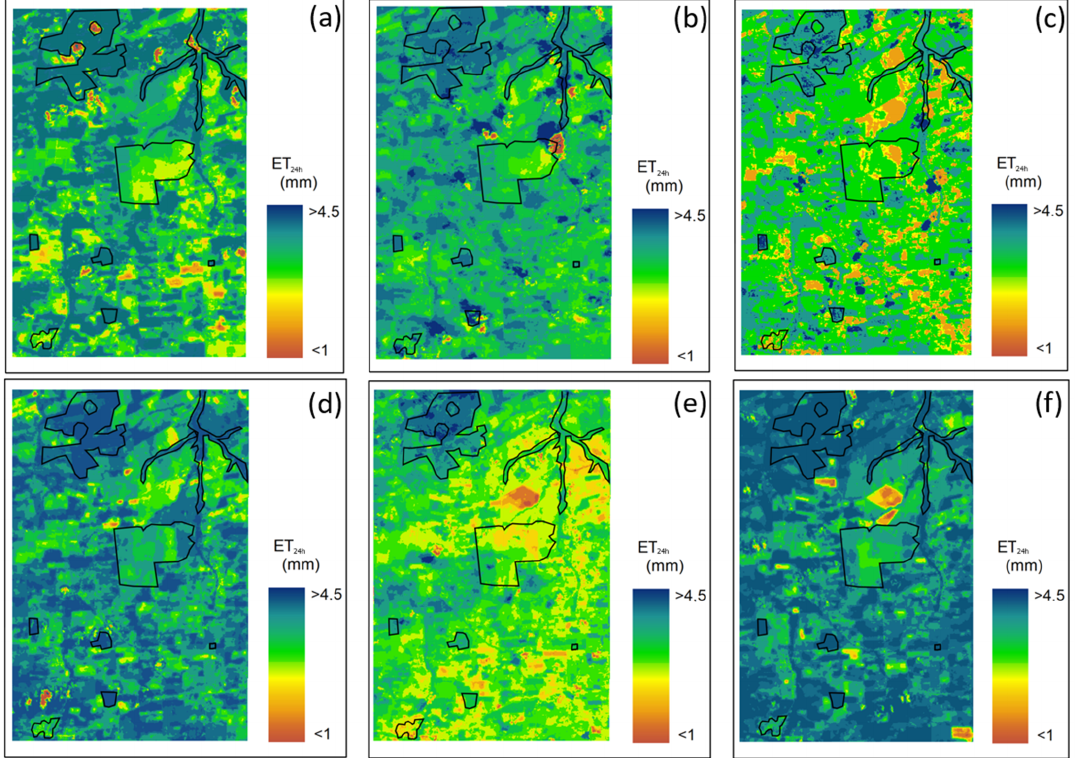
Figure 10. Temporal distribution of actual daily evapotranspiration (ET 24h ) on 20 November 2017 ( a ), 22 December 2017 ( b ), 31 May 2018 ( c ), 7 June 2018 ( d ), 26 June 2019 ( e ), and 29 August 2019 ( f ). Figure 11 represents the spatial variability of evapotranspiration in the açaí planta- tion plot estimated with the SEBAL algorithm for the images analyzed in this study over the periods evaluated.